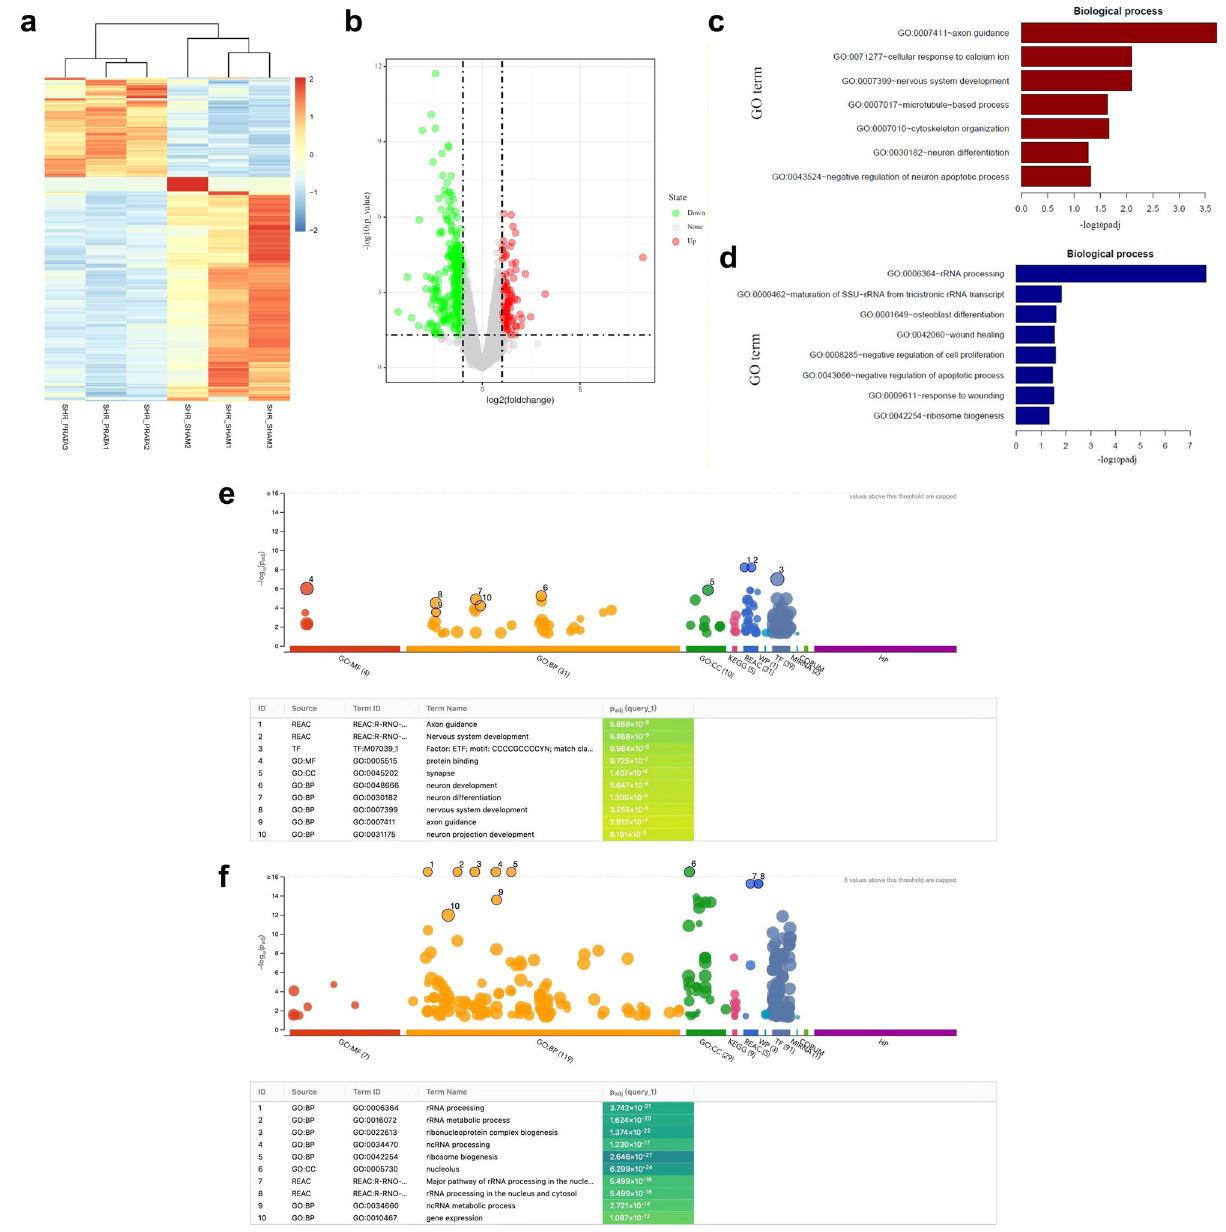
Fig. 4 Whole-transcriptome sequencing of isolated L1-L2 DRG neurons in SHRs. a , b Differential gene expression in L1-L2 DRG neurons 4 weeks post PRATA. Hierarchical cluster and volcano analysis of 433 genes expressed differentially between sham and PRATA groups. The expression levels are indicated by the increased gradient of dark blue to light blue to red intensity. c , d GO enrichment analysis shows most of those upregulated genes are associated with neuron plasticity and development, and those downregulated genes are prone to RNA processing and would healing. e , f Test of differential expressed gene abundances using g:Pro fi le showed that up-regulated genes mainly involved in neuron activities, while the downregulated genes enriched for RNA activities in post-PRATA SHRs compared with sham-operated